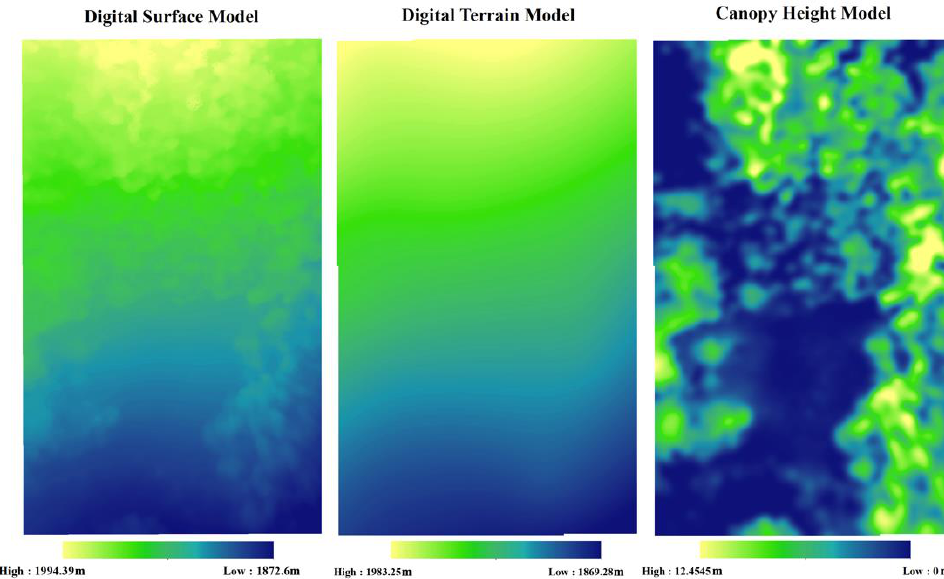
Figure 4. The digital surface model (DSM) ( a ), digital terrain model (DTM) ( b ), and canopy height model (CHM) ( c ) of the Baijixun plot.